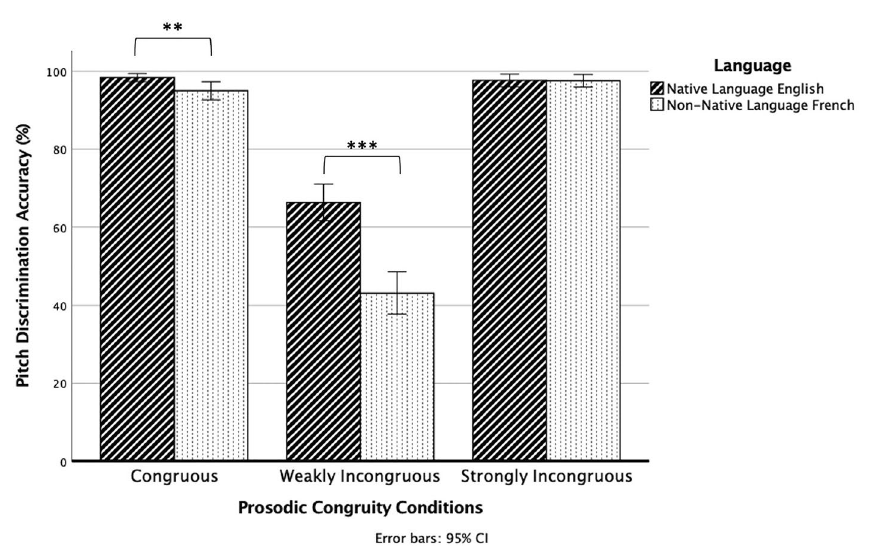
Figure 3. Pitch discrimination accuracy for the native language English and non-native language French in the three prosodic conditions. Error bars denote standard error. ** p < 0.01, *** p <